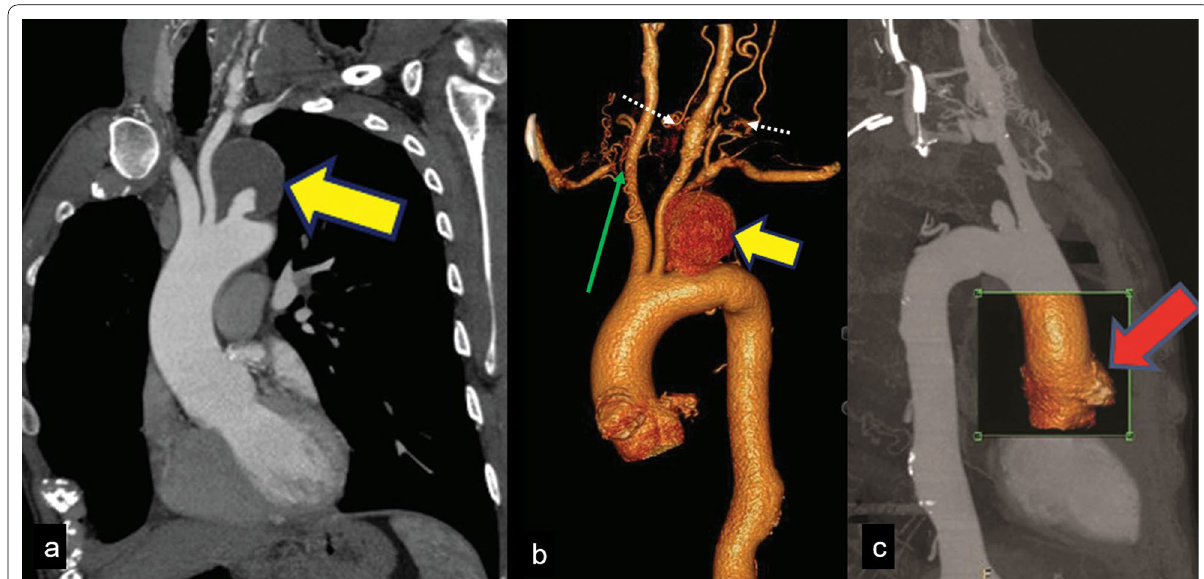
Fig. 1 a CT angiogram in coronal oblique plane showing aneurysm (yellow solid arrow) in proximal left subclavian artery with thrombosis of lumen. b Distal to thrombosed aneurysm (yellow solid arrow) left subclavian artery is filled through collaterals from left external carotid artery (white dotted arrow) in VRT image. Note is also made of proximal short segment occlusion of right subclavian artery (green arrow). c CT angiogram VRT image showing aneurysmal dilation of right coronary ostium (red arrow)